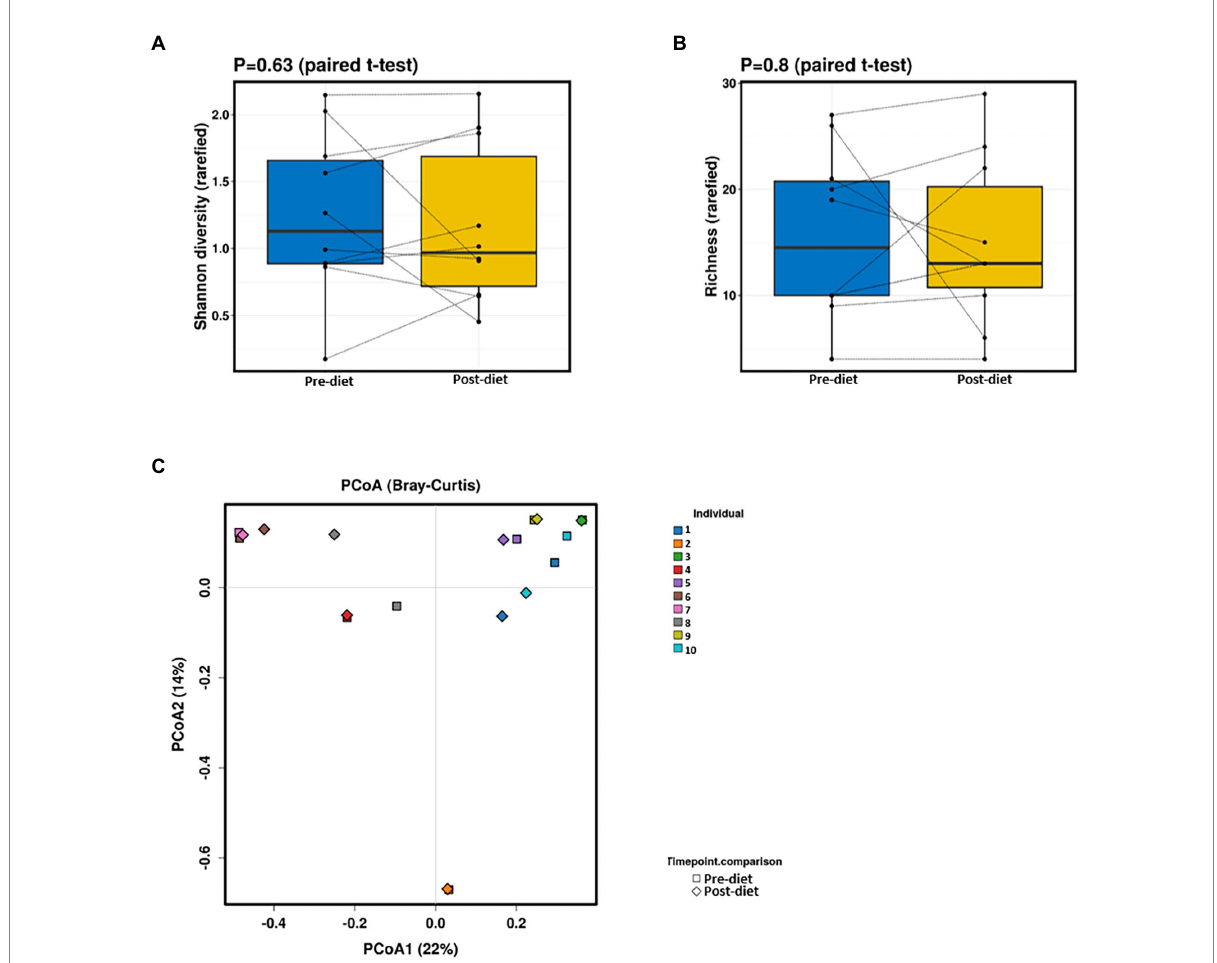
FIGURE 5 No significant differences in infant gut alpha-diversity [Shannon diversity index (A) or richness (B) ] were detected between pre- and post-diet samples (blue and yellow, respectively). Principal coordinates analysis (PCoA) (C) of Bray–Curtis distances showed no significant differences between pre-diet and post-diet